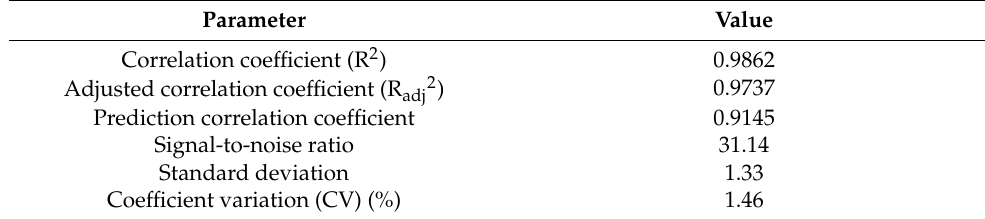
Table 4. Reliability analysis of the quadratic equation